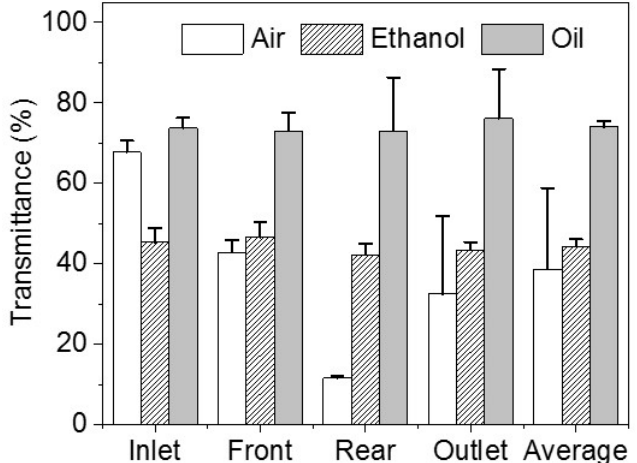
Figure 4. Transmittance of the chips after removing inner sacrificial materials with different removers. The transmittances of four parts are calculated: the inlet of the chips, the front part of the chips, the rear part of the chips, and the outlet of the chips. The average transmittance of the four parts represents the transmittance of the chips.